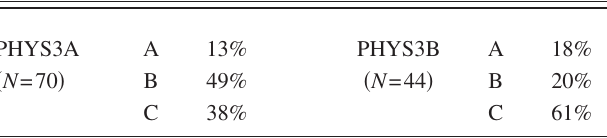
TABLE VI. Results for Q2- (cid:1) II (cid:2) for two recent semesters of PHYS3.